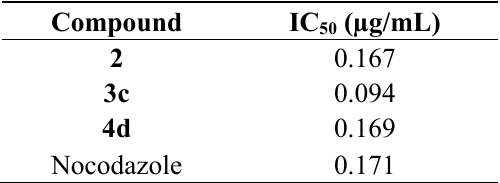
Table 2. Cytotoxic effects of compounds 2 , 3c , 4d and nocodazole against human breast adenocarcinoma cell line (MCF-7 cells) using the xCELLigence Real Time Cell Analysis (RTCA)